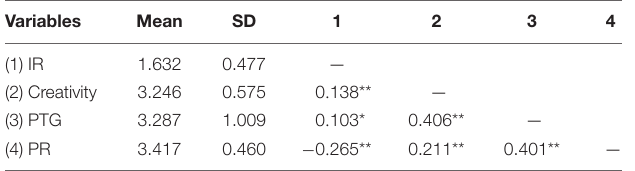
TABLE 2 | Descriptive statistics and correlations among